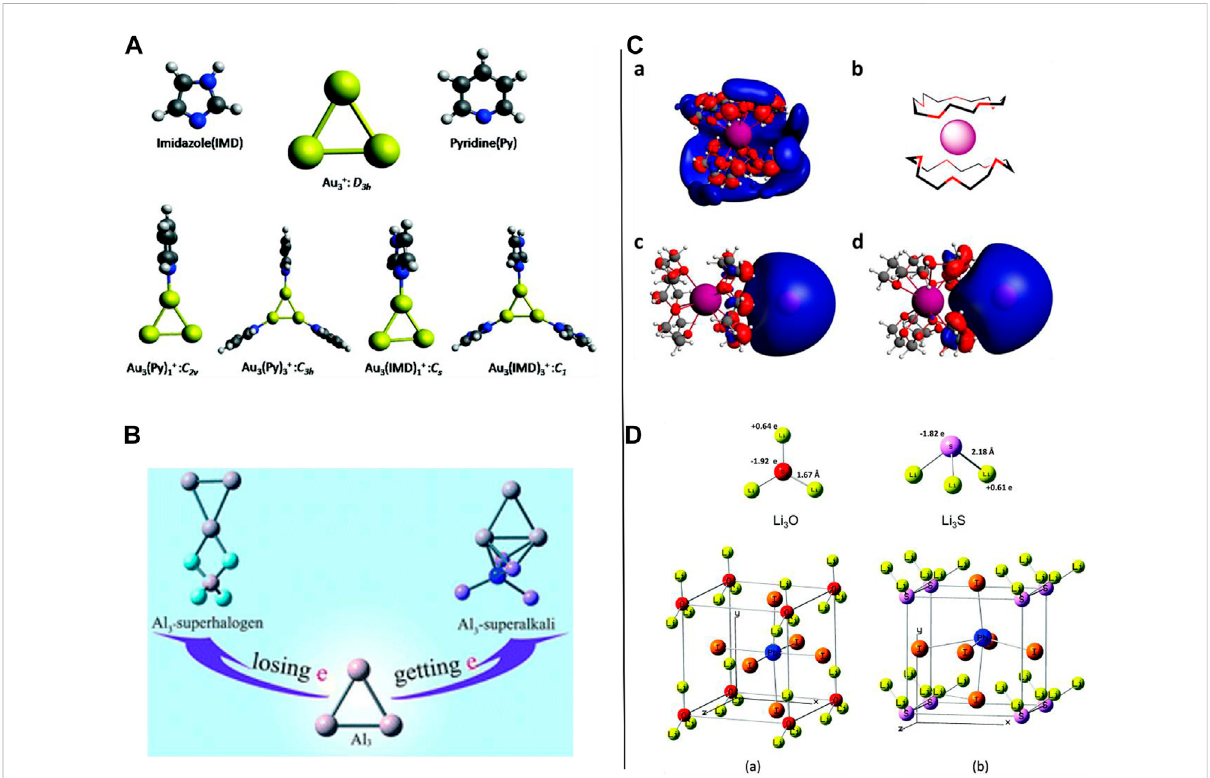
FIGURE 5 (A) Optimized geometries of the ligands and the Au 3 -coupled complexes reproduced with permission from Parida et al. (2018); (B) representativeAl 3 -MandAl 3 -XsuperatomcompoundswhereMisa(super)alkali(M=Li,FLi 2 ,OLi 3 ,andNLi 4 )andXisasuperhalogen(X=F,LiF 2 ,BeF 3 , andBF 4 )reproducedfromYangetal.(2018)withpermissionfromtheRoyalSocietyofChemistry; (C) computedSOMO/HOMO3Disosurfacesofthe superalkaliK-15-crown-5 2 model (a) andsuperalkali − alkalide(K-15-crown-5 2 ) δ + (Na) δ − withthealkalideintheaxialreproducedfromRiedeletal. (2021) (c) and equatorial (d) positions with respect to the sandwich complex [as illustratedin theform of a cartoon (b) ]; (D) optimized